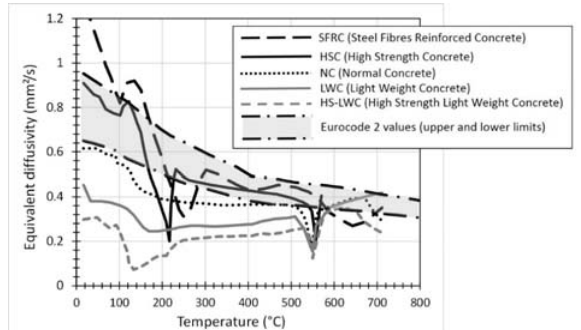
Figure 4. The thermal diffusivity for different concretes recalculated from experiments on cylinders [31]. The Eurocode curve in the figure is omitting the influence of